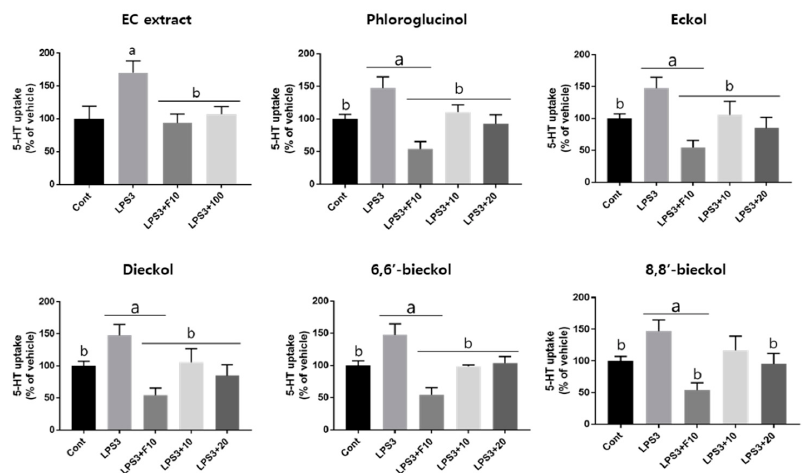
Figure 5. EC inhibited LPS-induced 5-HT uptake in RBL-2H3 cells. RBL-2H3 cells were seeded in a 24-well plate (5 × 10 5 cell/well) and treated with 3 μ g/mL LPS, followed by treatment or absence of fluoxetine (10 μ M) and EC at different concentrations (10 or 20 μ g/mL) for 16 h. Experiments were conducted in triplicate and data are expressed as means ± SD. a p < 0.05 versus control, b p < 0.05 versus LPS 3 μ g/mL.